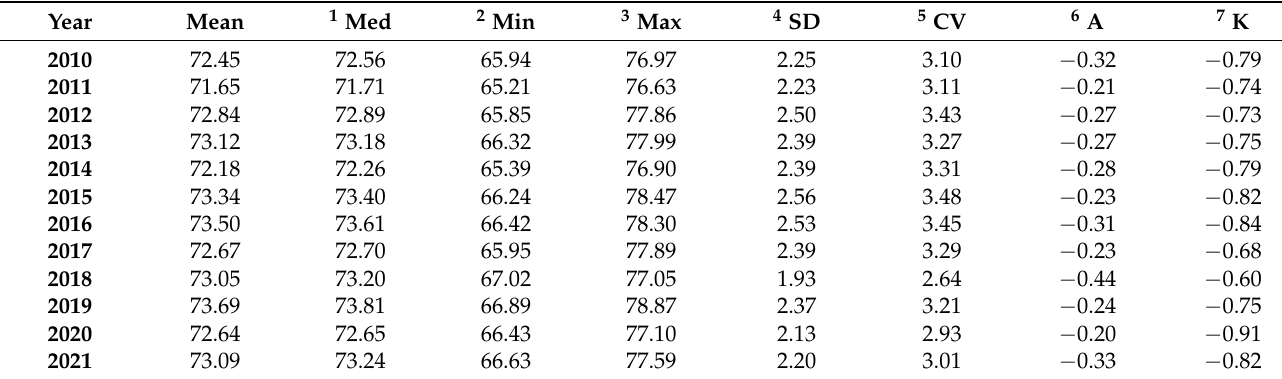
Table 1. Summary of descriptive statistics of annual THI values.